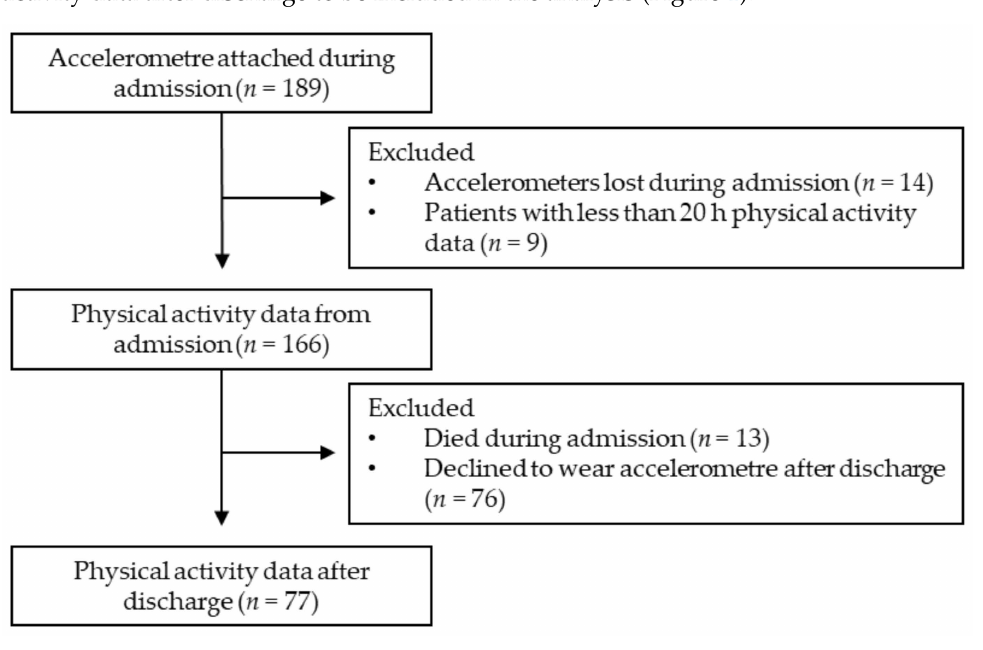
Figure 1. Flow chart of the study